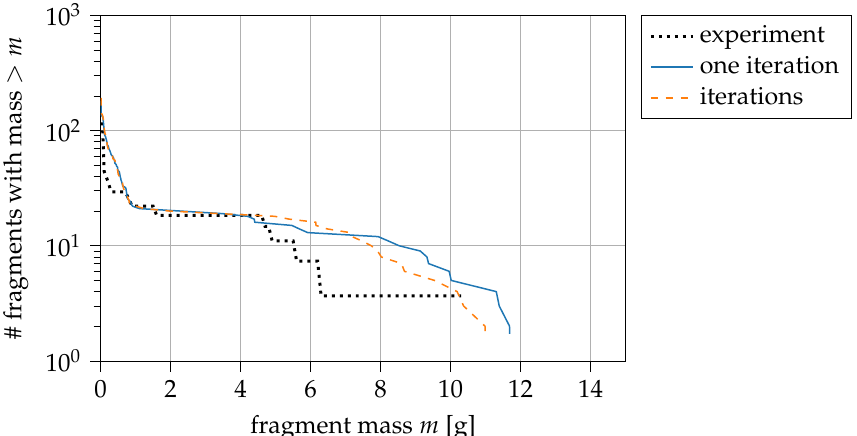
Figure 9. Influence of using several Newton–Raphson iterations instead of only one iteration; experiment from